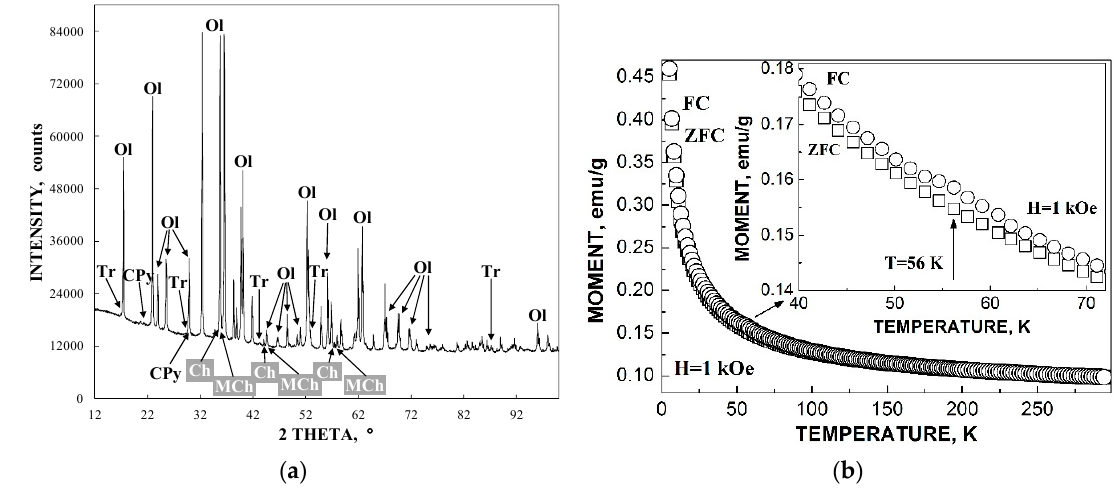
Figure 7. Stony part of Seymchan main group pallasite: ( a ) X-ray diffraction pattern with indication of some reflexes of the iron-bearing phases: Ol is olivine, CPy is clinopyroxene, Tr is troilite, Ch is chromite, and MCh is magnesiochromite. ( b ) Zero-field-cooled (ZFC) and field-cooled (FC) magnetization curves with inset which shows enlarged part of ZFC/FC curves indicated a small bulge, probably related to the phase transition in chromite. Adopted from [15].